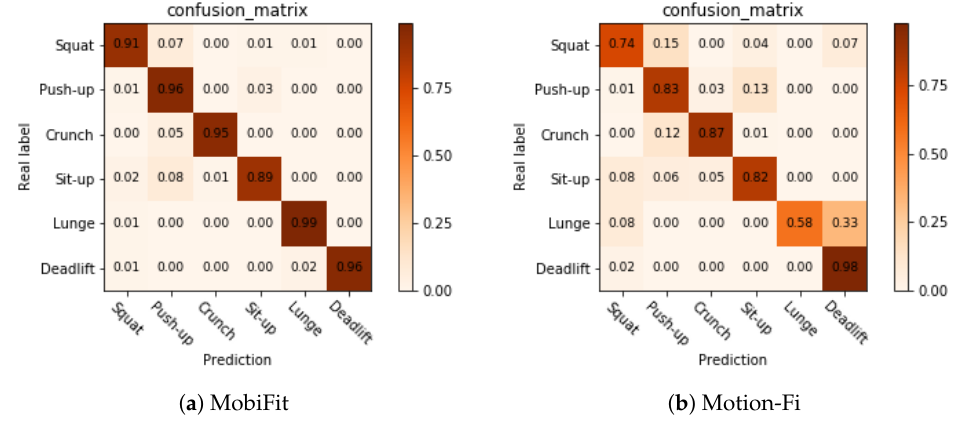
Figure 20. Comparison on confusion matrix of type recognition for Volunteer v 3